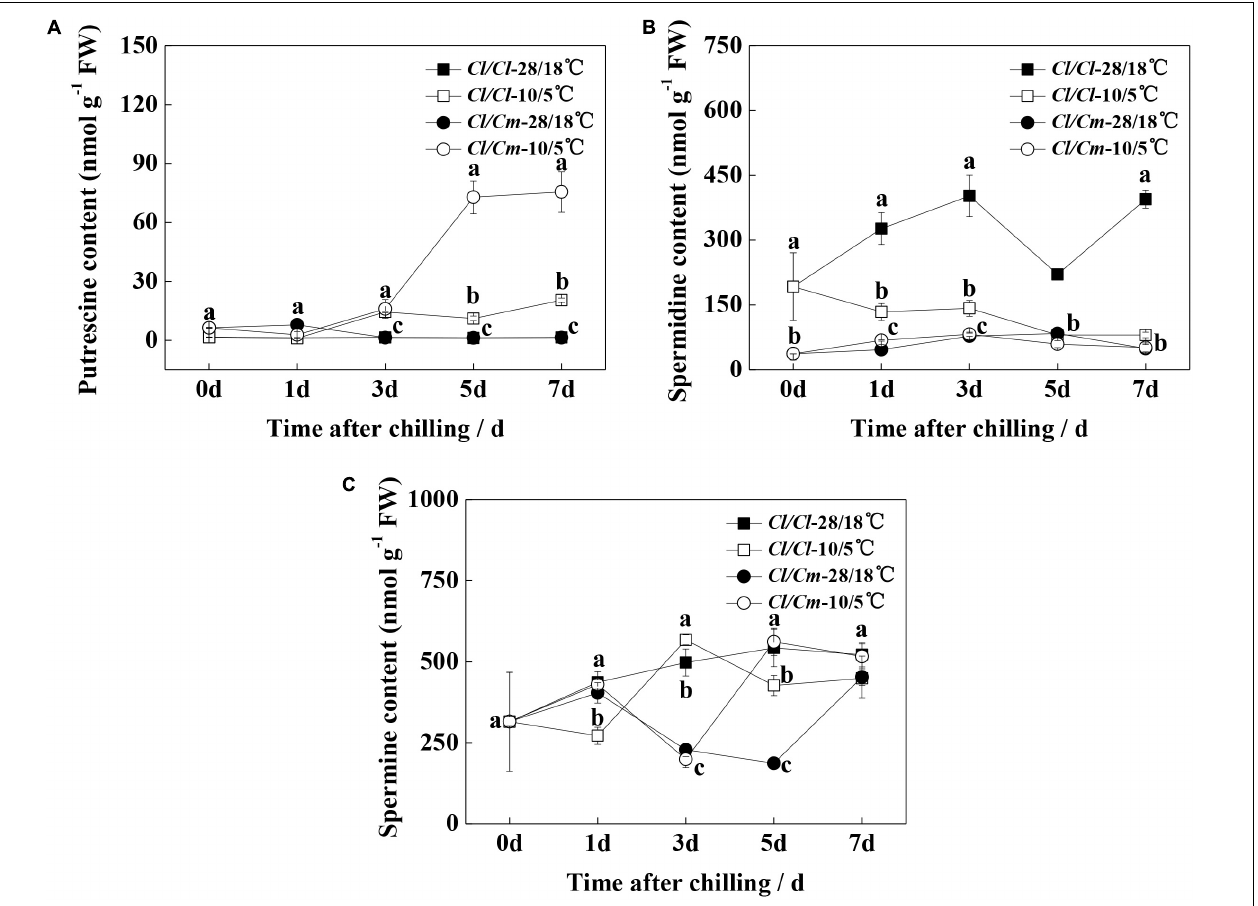
FIGURE 2 | Effects of pumpkin rootstock on polyamine accumulation in watermelon leaves under chilling stress. (A) Content of putrescine. (B) Content of spermidine. (C) Content of spermine. Values are means ± SE ( n = 4). Different letters indicate the significant differences among various treatments at the same time ( P < 0.05, one-way